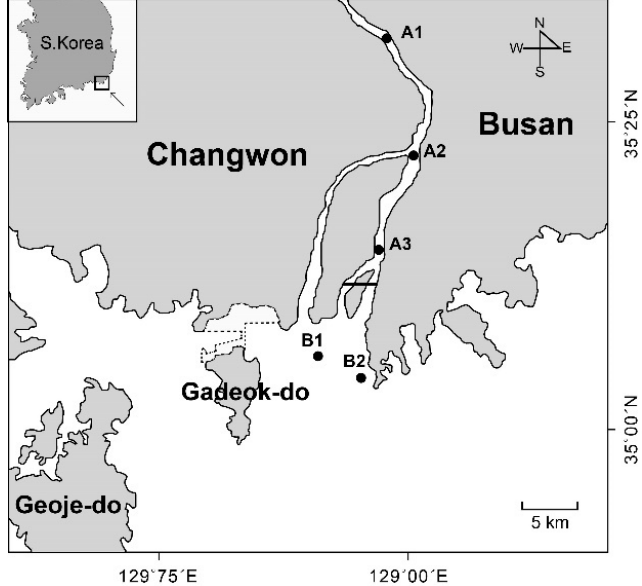
Figure 1. Sampling stations from freshwater (A1, A2 and A3) and estuary (B1 and B2)